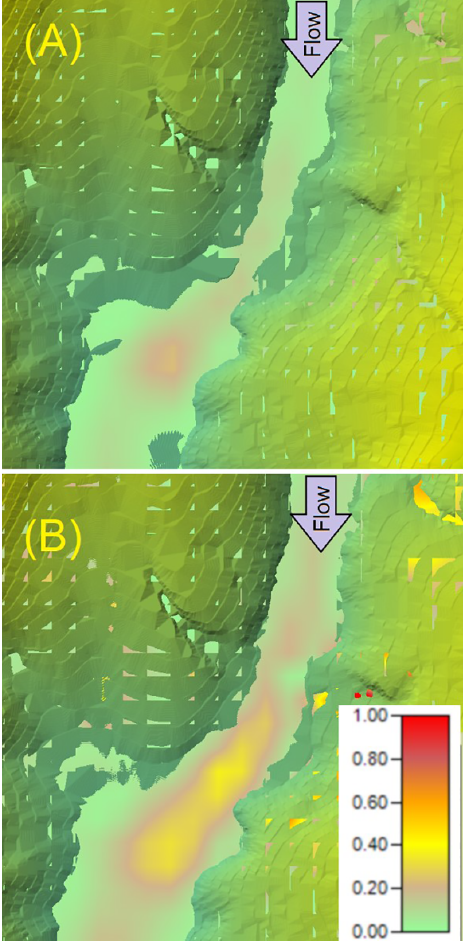
Figure 11. Comparison between Shear Stresses in the Channel Ob- tained with the Large Trapezoidal (a) and Small Trapezoidal (b) Cross Section